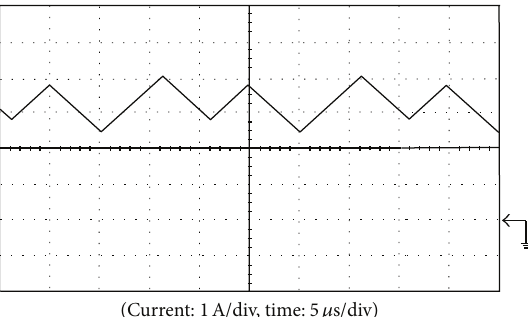
Figure 23: Measured output inductor current while hybrid wind-PV power is 700W.